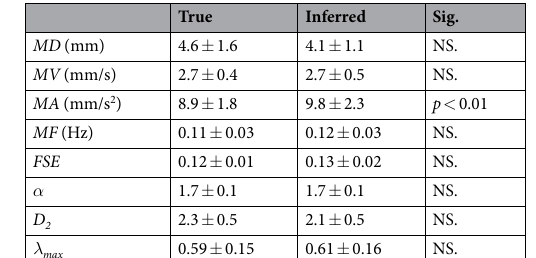
True Inferred Sig. MD (mm) 4.6 ± 1.6